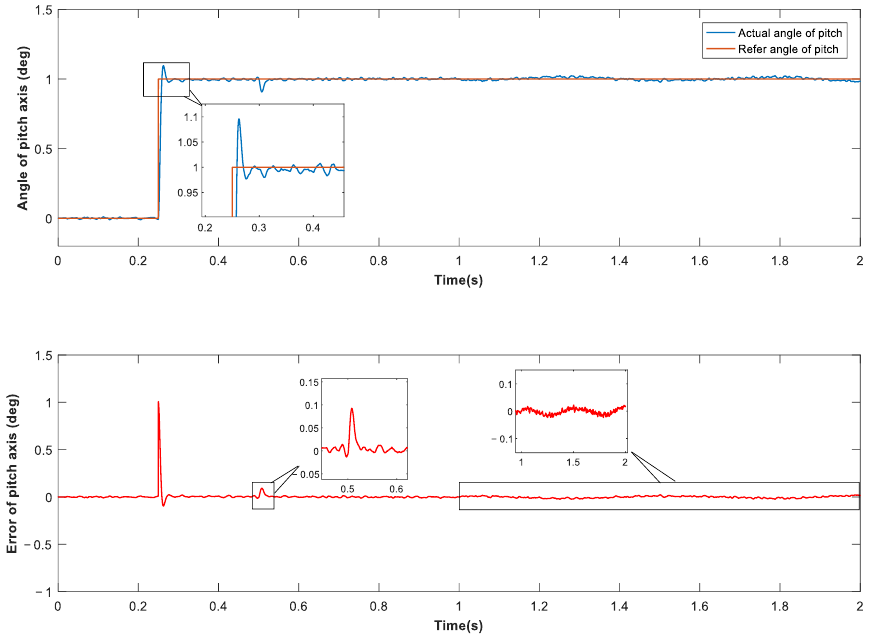
Figure 8. Response of pitch axis with cross-feedback module under CMAC–PID control.